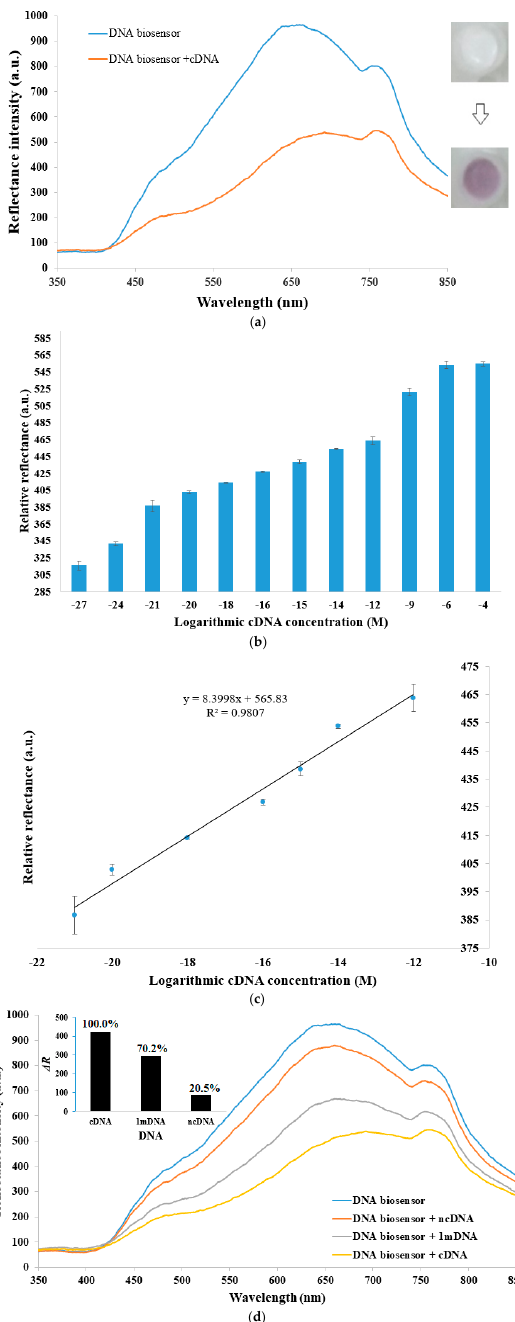
Figure 2. ( a ) Optical reflectance detection of 1 pM dengue virus cDNA at pH 7.0 and 637 nm via sandwich hybridization process using 4 µM immobilized pDNA and 20 nM immobilized rDNA with the gold–latex sphere label. The inset shows the color appearance of the DNA micro-optode before and after reaction with the target DNA–AuNP–latex. ( b ) Relative reflectance response at 637 nm between DNA biosensor reflectance spectra before and after sandwich hybridization reaction in the cDNA concentration range of 1 × 10 − 27 M to 1 × 10 − 4 M ( n = 3). ( c ) The linear response range of the DNA biosensor between 1.0 zM and 1.0 pM ( n = 3). ( d ) Selectivity assessment of the DNA biosensor toward the determination of cDNA, ncDNA, and 1mDNA at 1 × 10 − 16 M and 637 nm.